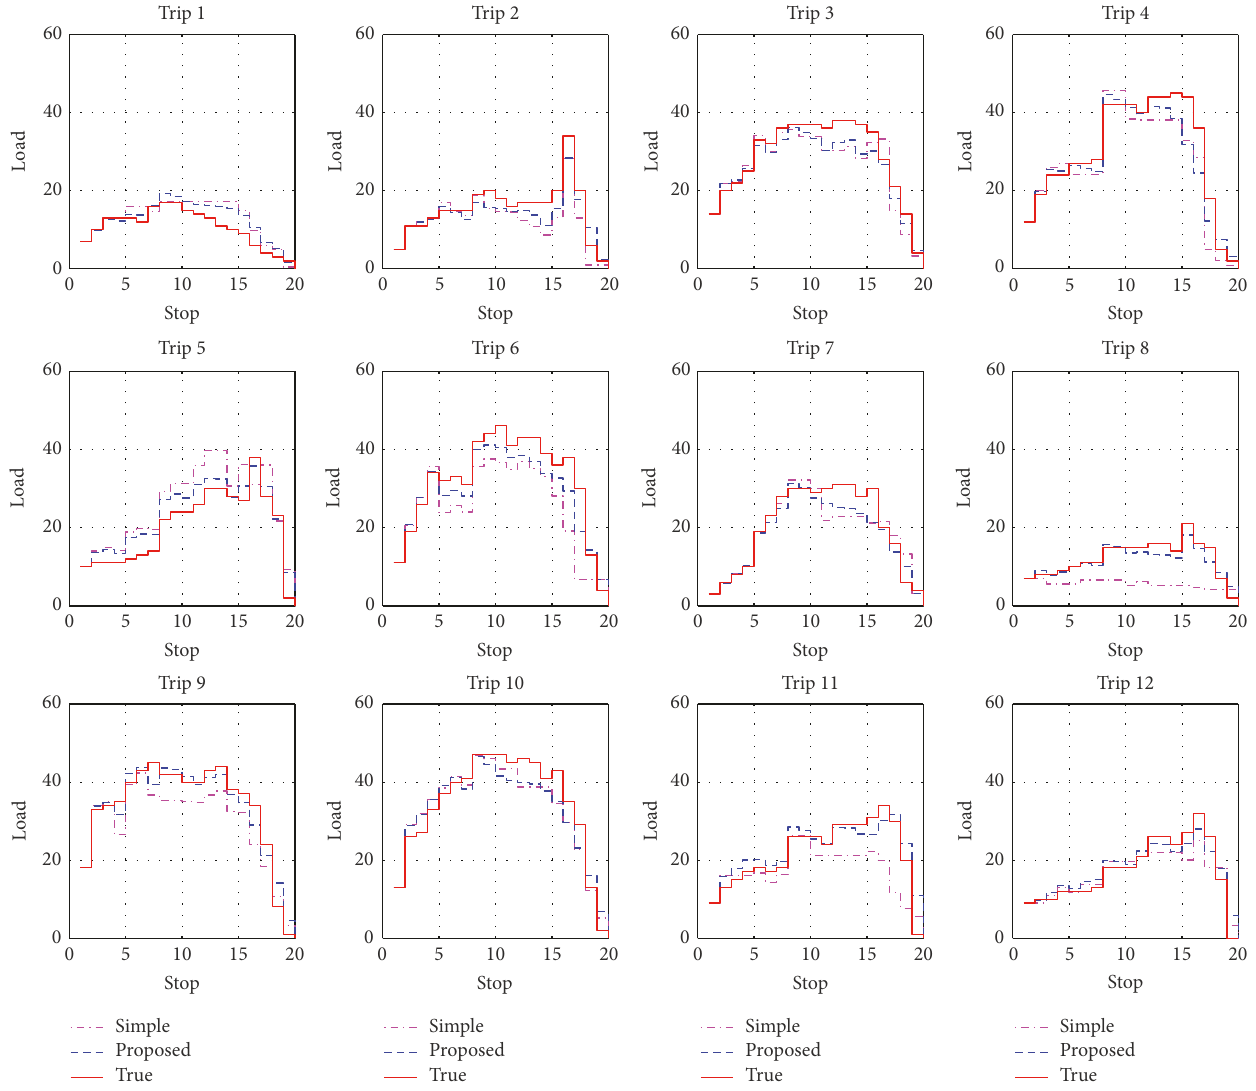
Figure 2: Estimated and true bus load